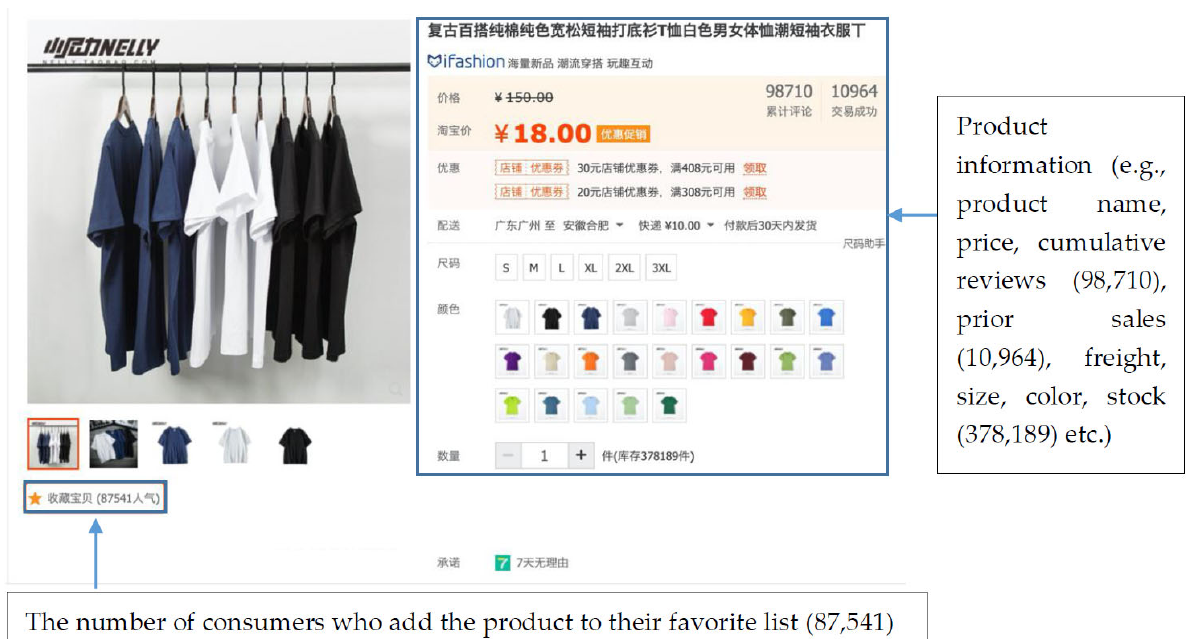
Figure 2. Product consideration (source: https://www.taobao.com/) (accessed on 9 November 2020).